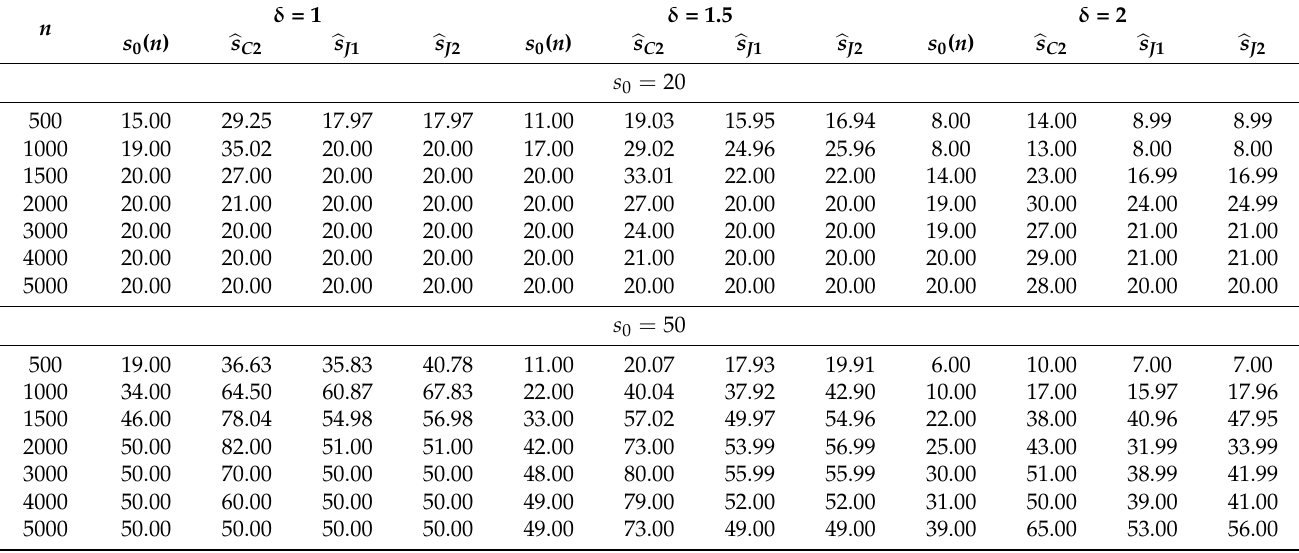
Table A2. Numbers of species in two populations are s 1 = 100 & s 2 = 100, and the number of shared species s 12 = 20 or s 0 = 50 for the case of Zipf’s law ( J 1 & J 2: 1st & 2nd Jackknife estimates, C 2: Chao’s estimate, s 0 ( n ): number of observed shared